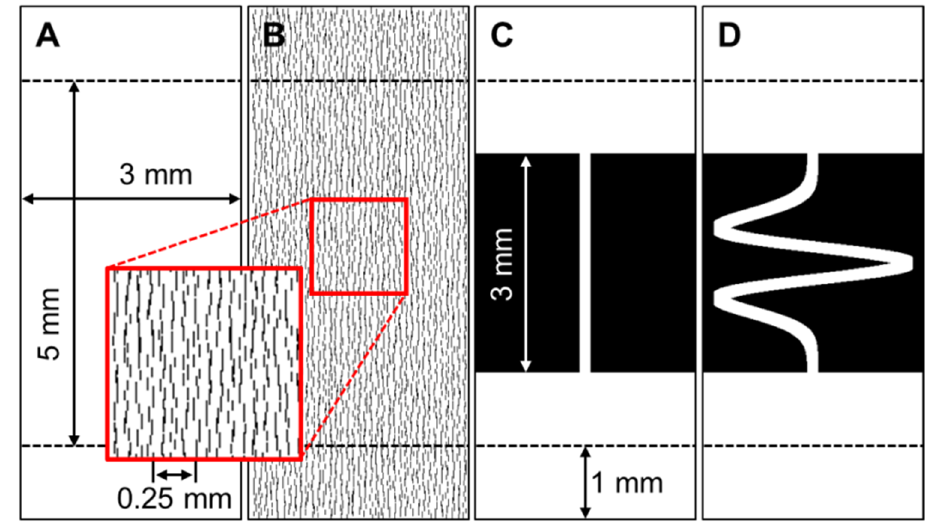
Figure A1. Model domains. Areas in white are viable myocardium, and areas in black are the equiv- alent of a non-conductive scar. All models are 7 by 3 mm, but for comparison purposes, only the central 5 mm section is used to mitigate top and bottom boundary effects. ( A ) Isotropic domain. ( B ) Laminar cleft domain. Clefts are around 50 μ m apart. ( C ) A simple model of a tissue tract crossing the scar region with constriction and expansion. ( D ) A tortuous tissue tract crossing the scar region. The tortuous tract is 9.05 mm in length.